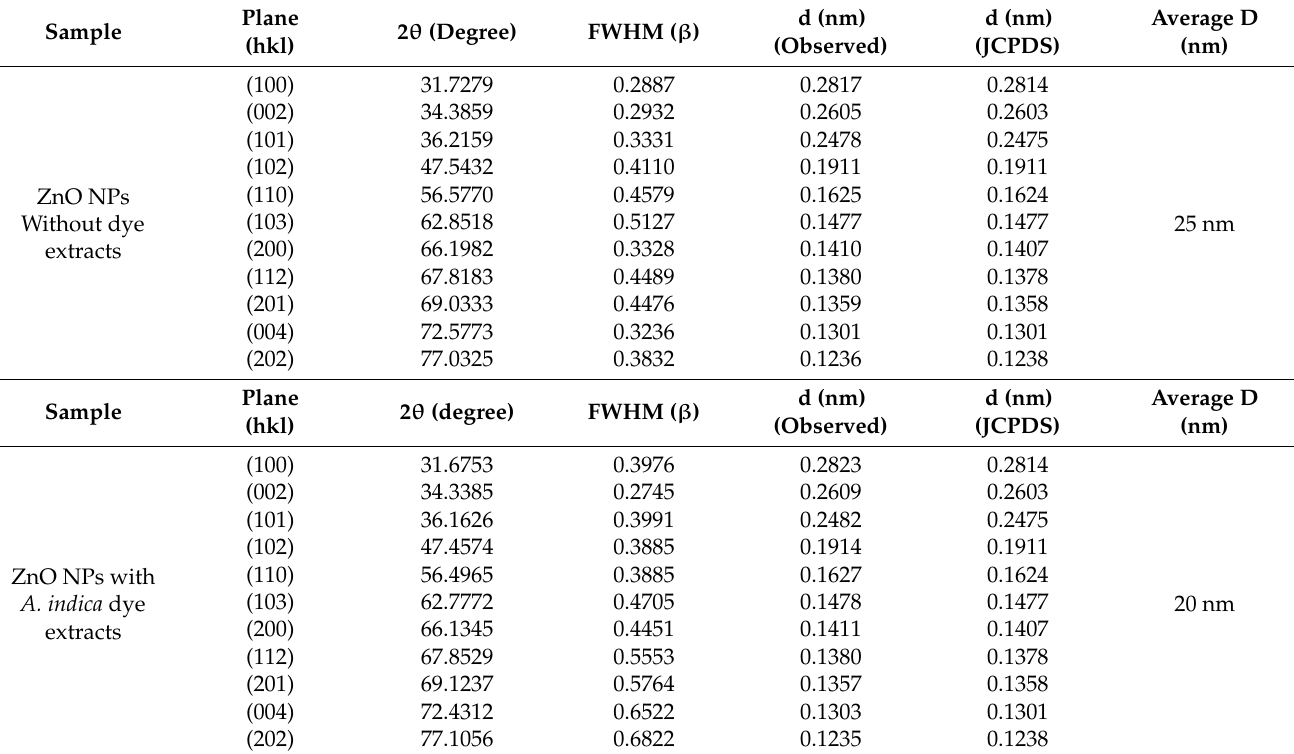
Figure 1. X-ray diffraction pattern of ZnO NPs prepared ( a ) without plant dye extracts and ( b ) with A. indica dye extracts. Table 1. Calculation of d-spacing and crystallite size of prepared ZnO NPs.